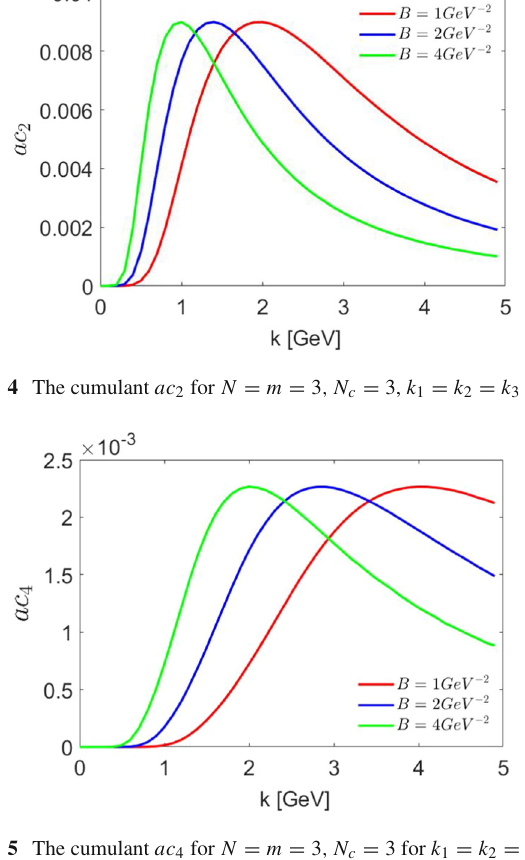
Fig. 5 The cumulant ac 4 for N = m = 3 , N c = 3 for k 1 = k 2 = k 3